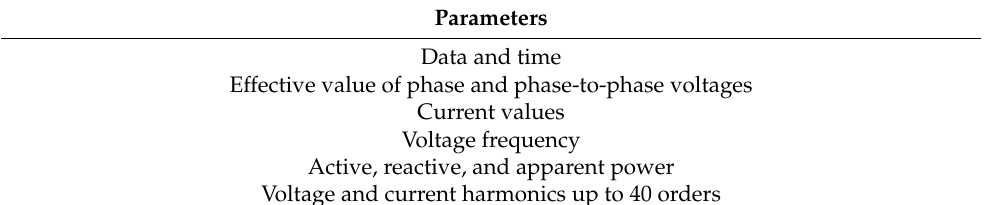
Table 3. Parameters registered by Sonel’s PQM-700